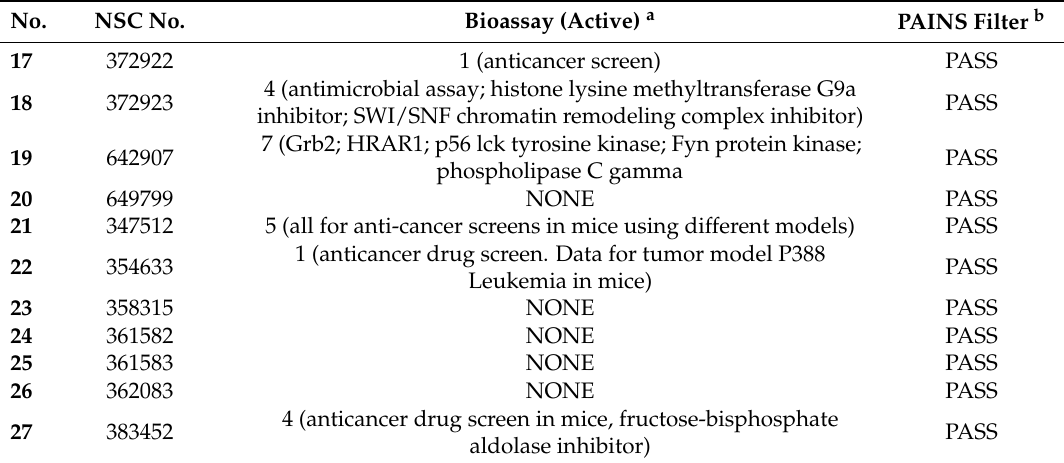
Table 5. The investigation results based on PubChem database and the PAINS